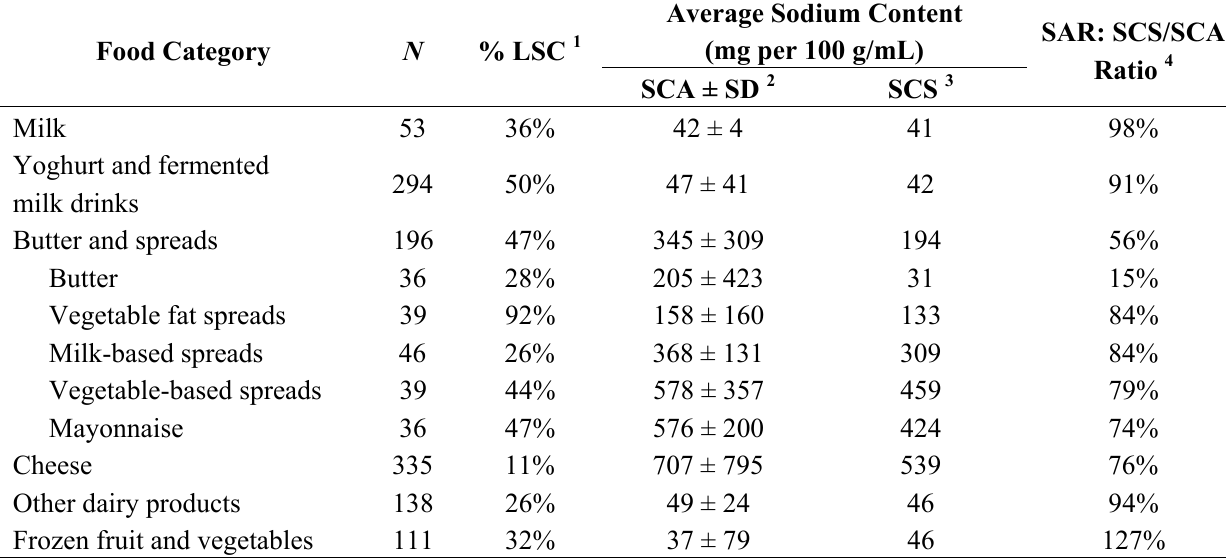
Table 1. Average sodium content in available (SCA) and sold (SCS) prepacked foods for selected food